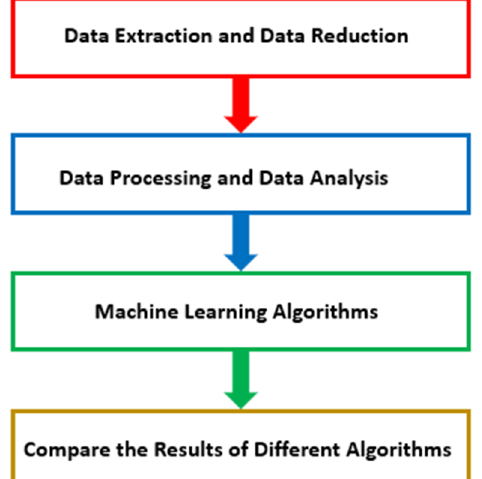
Figure 1. Methodology. Figure 1.